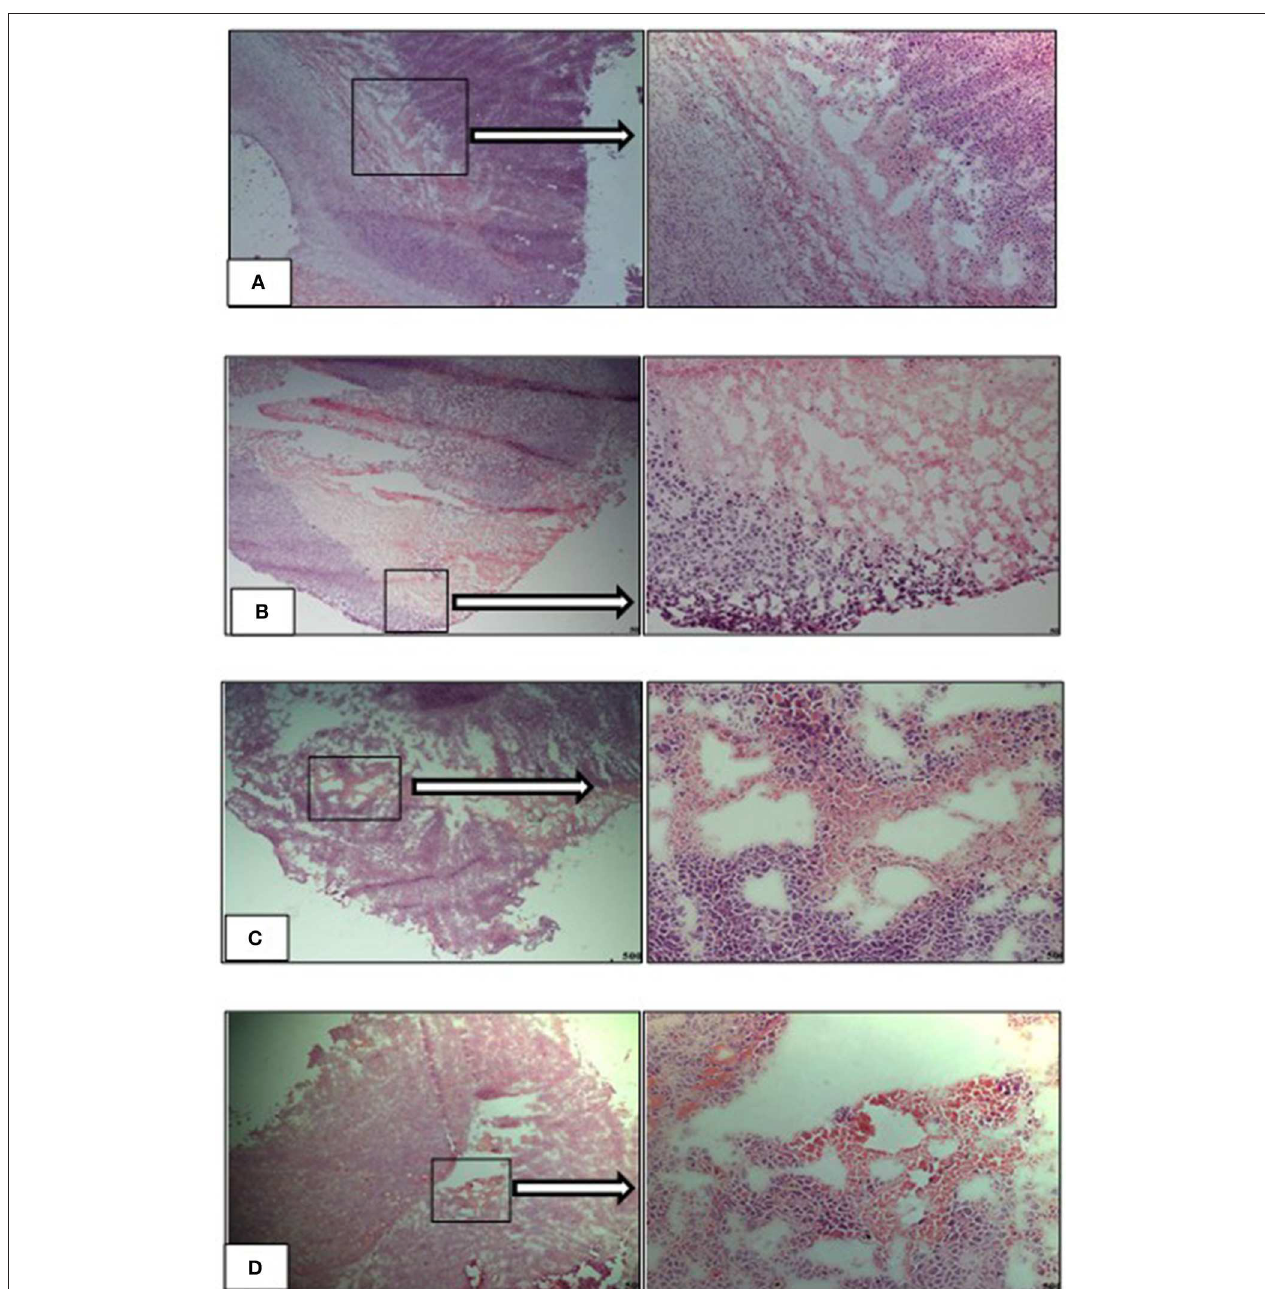
FIGURE 12 | Representative images of H&E stained tumor sections of the experimental treatment groups (A) vehicle-LFD, (B) vehicle-HFD, (C) Dox-L, (D) Dox-H, Magnification = 4 and 20 x. Scale = 500 µ m.